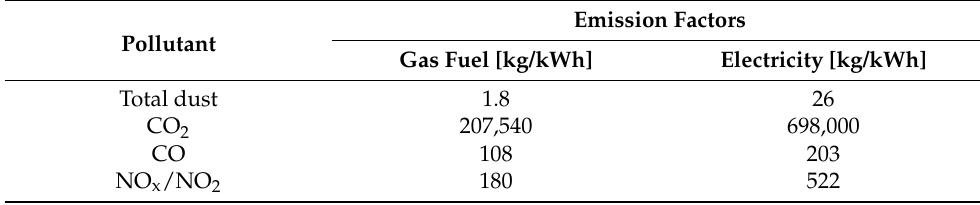
Table 2. Emission factors of selected